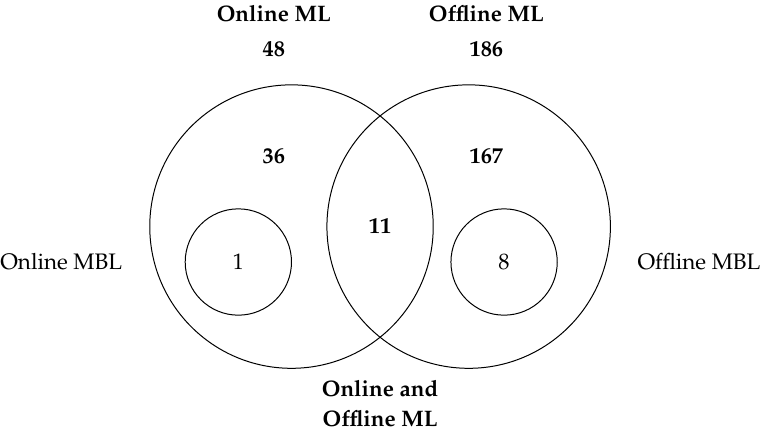
Figure 9. Distribution of online and offline ML (number of